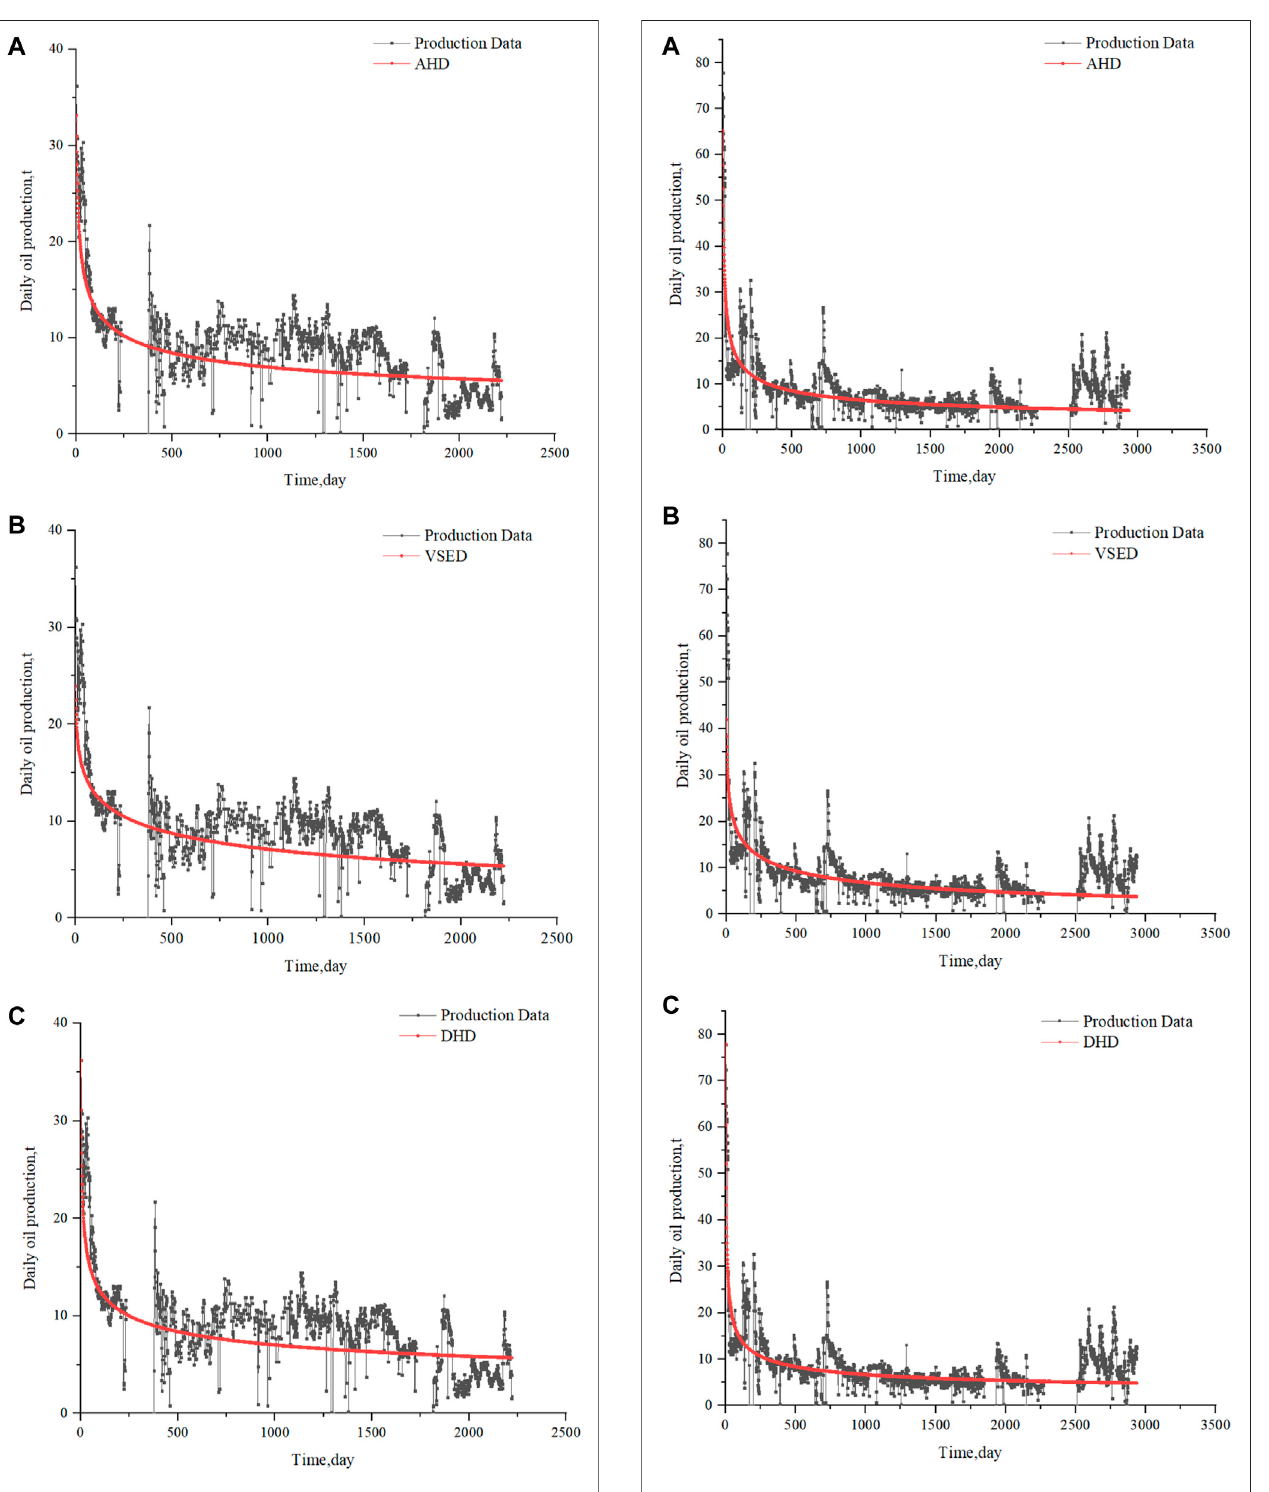
FIGURE 10 | Three decreasing fi tting curves of Well JHW018: (A) AHD fi tting curve of Well JHW018, (B) VSED fi tting curve of Well JHW018, and (C) DHD fi tting curve of Well JHW018.